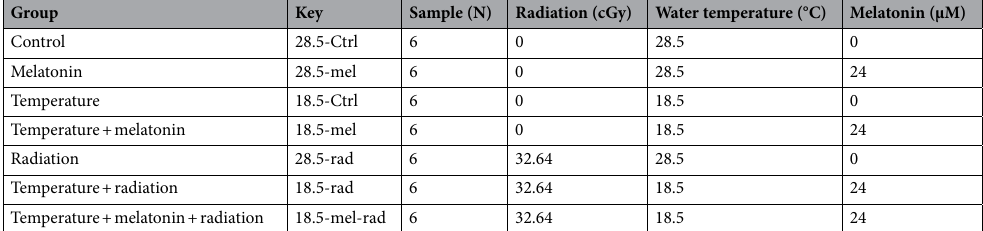
Table 1. Experimental groups showing the group names, key, sample number per condition, values of radiation exposure, ambient water temperature, and melatonin